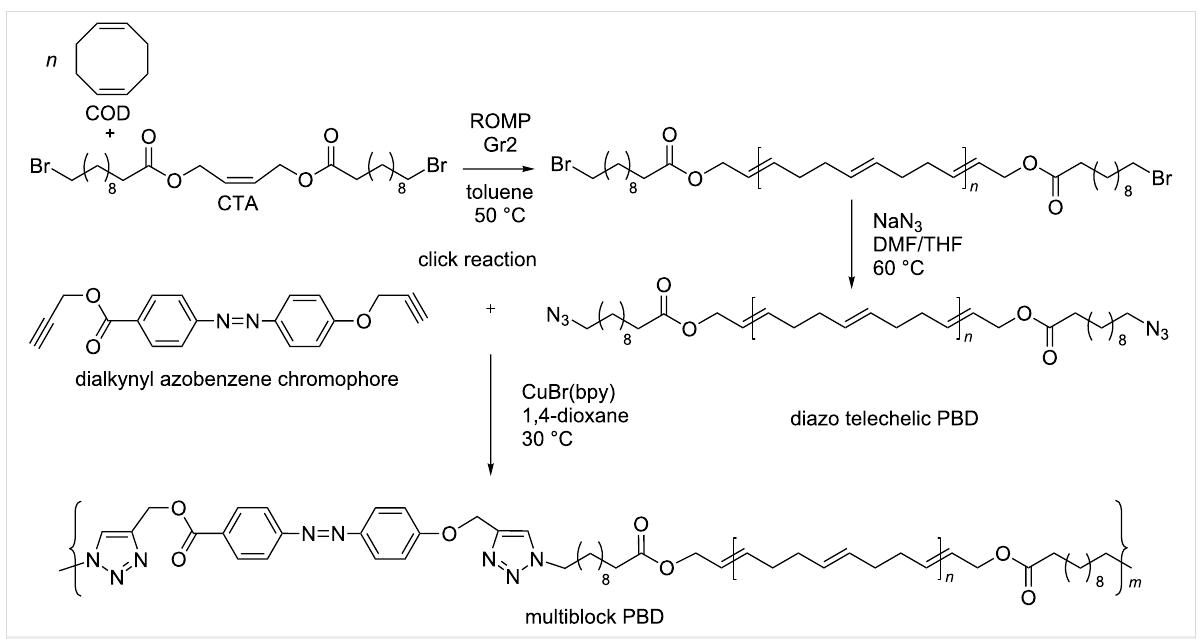
were synthesized in the presence of Gr1 and terminated by the reaction with NB–(PPE–PMI)–NB to obtain the ABCBA pentablock